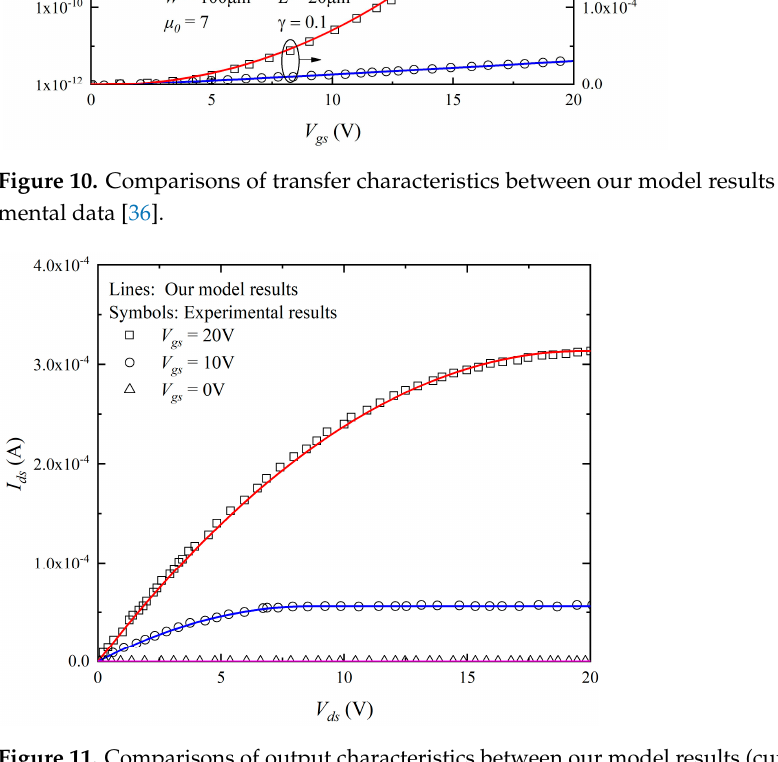
Figure 11. Comparisons of output characteristics between our model results (curves) and experi- mental data [36].